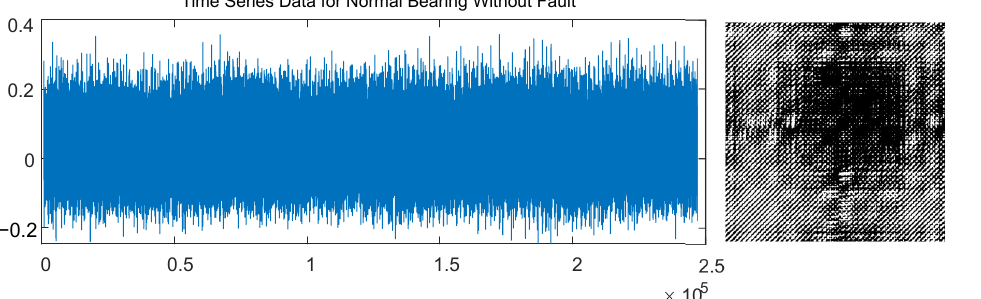
Figure 1. The standard recurrence plot generated by a normal bearing vibration signal without a fault (the dataset of Case Western Reserve University School of Engineering [33]). The threshold parameter ε is set to 0.253 which results in an equal proportion of black and white